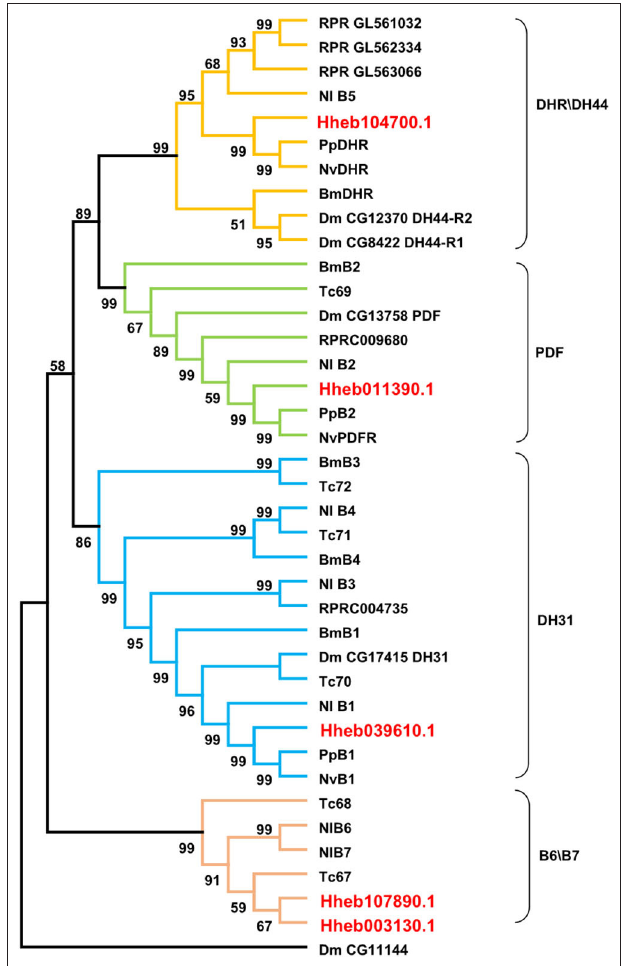
FIGURE 5 | Phylogenetic tree analysis of the family B neuropeptide GPCRs from H. hebetor (Hh), B. mori (Bm), D. melanogaster (Dm), P. puparum (Pp), N. vitripennis (Nv), Nilaparvata lugens (Nl), Rhodnius prolixus (RPR), and T. castaneum (Tc). The numbers at the nodes of branches indicate the posterior probability for each branch. The red labels are from H. hebetor . The amino acid sequences used are listed in the Supplementary Material File 4 .